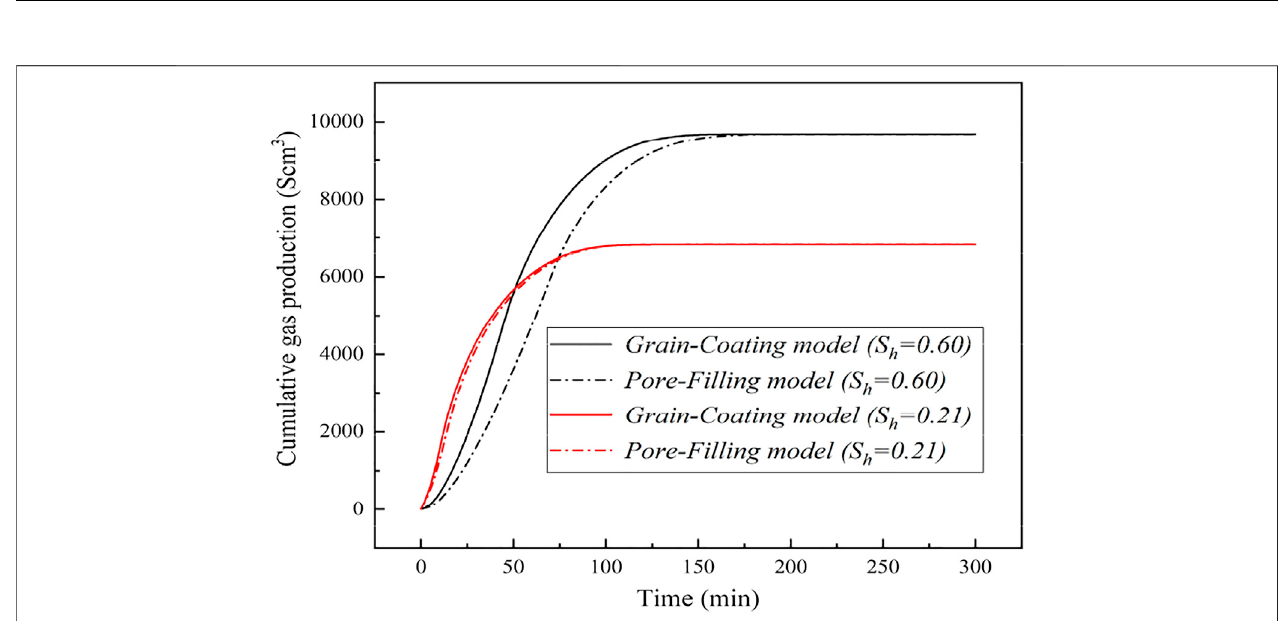
FIGURE 11 | The changes of cumulative gas production for different permeability models at the hydrate saturations of 21% and 60%.